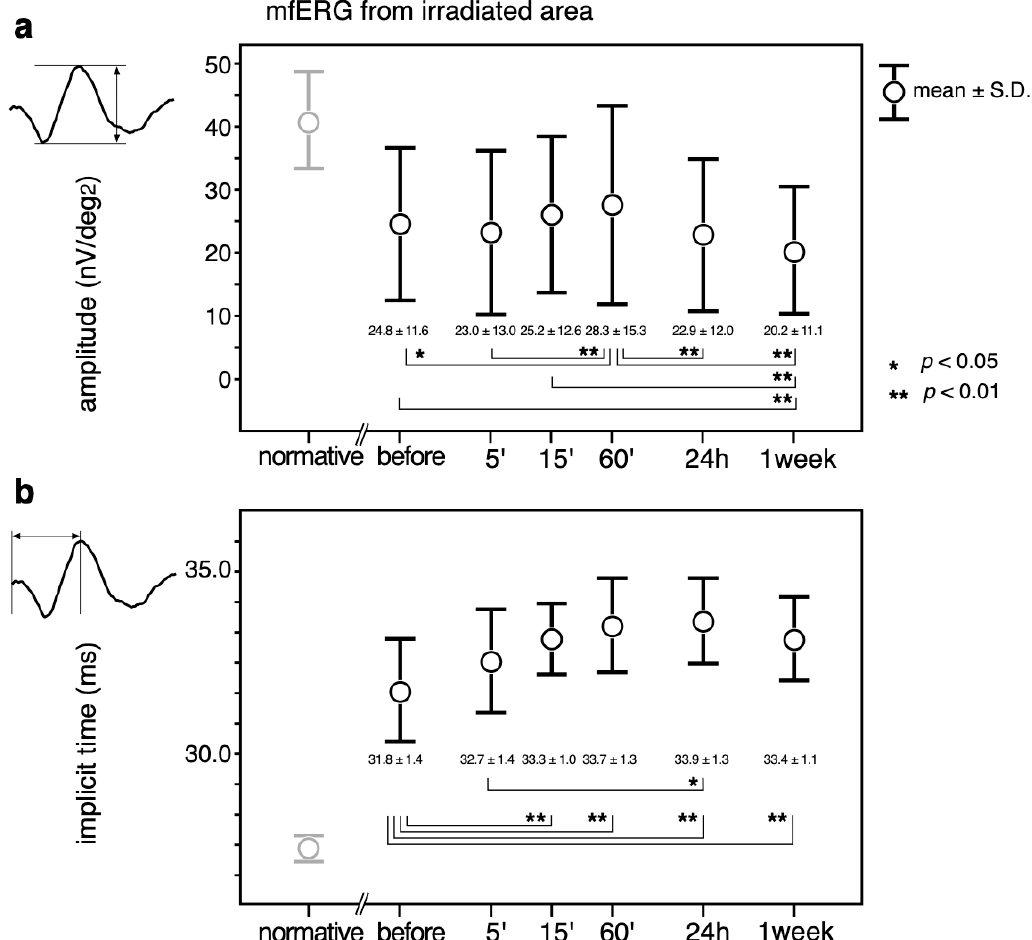
Figure 4. Mean ± standard deviations over the time course of the changes in the amplitudes ( a ) and implicit times ( b ) of the mfERGs recorded from the irradiated area. Transitions, 2-combination from 6 time points; 15 comparisons were statistically analyzed by a paired t -test with Bonferroni correction. A p value less than 0.05 (*) was considered statistically significant. A p- value less than 0.01 was marked with **. Normative mfERG obtained from 8 healthy volunteers are also plotted (left most column, pale circles and error bars) to show that the mfERG from the irradiated area was altered by diabetic changes even before the PC. Normative values were not included in the statistical analysis. The largest amplitudes were recorded at 60’, which was significantly larger than those before ( p < 0.05) and at 5’, 24 h, and 1 week ( p < 0.01) after PC. The amplitude at 1 week was significantly smaller than the amplitude before and at 15’ and 60’ after the PC ( p < 0.01).